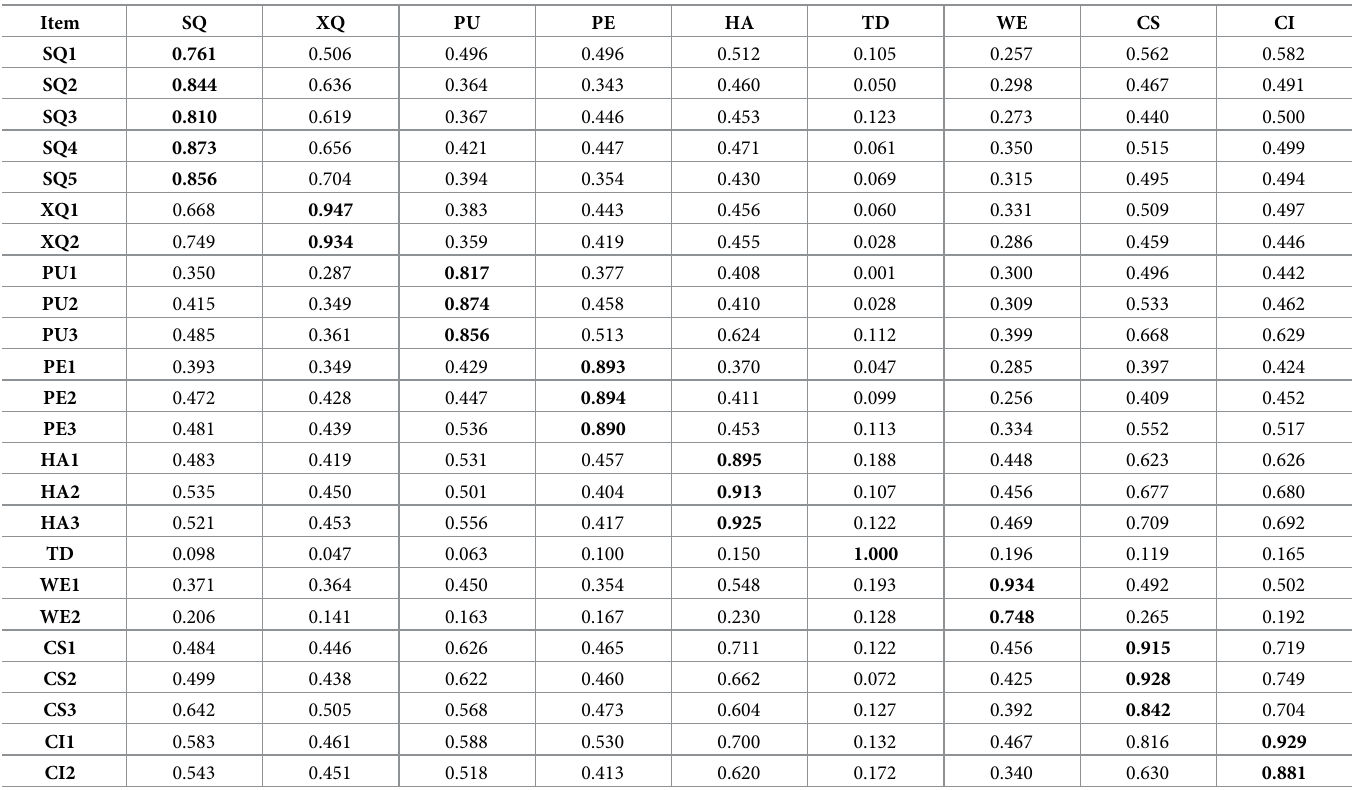
Table 4. Cross loadings.